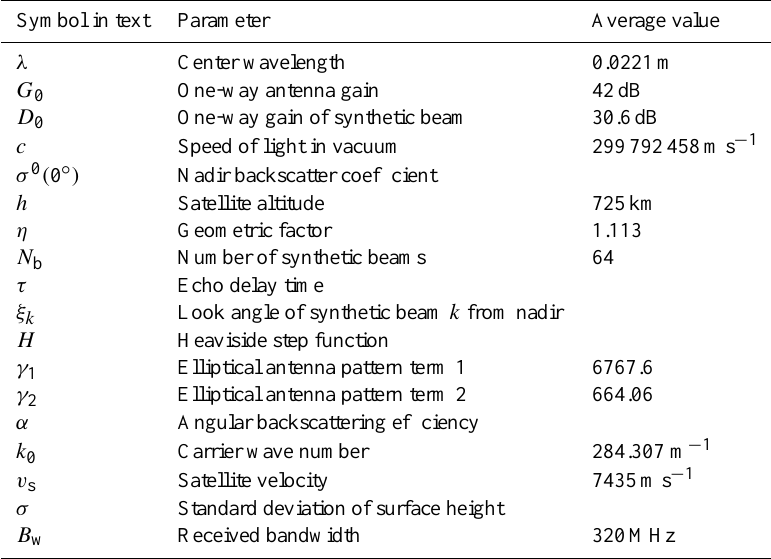
Table 1. Summary of parameters and symbols used in the CryoSat-2 model. Symbol in text